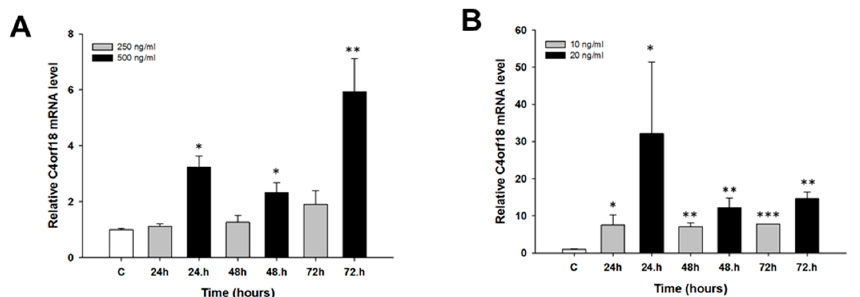
Figure 7. Expression analysis of the S100A3 gene in: W1 ( A ); and A2780 ( B ) ovarian cancer cell lines. The figure presents the relative gene expression in TOP-treated cells (grey and black bars) with respect to the untreated control (white bars), assigned as 1. The values were considered significant at * p < 0.05 and ** p < 0.01. Molecules 2017 , 22 , 717